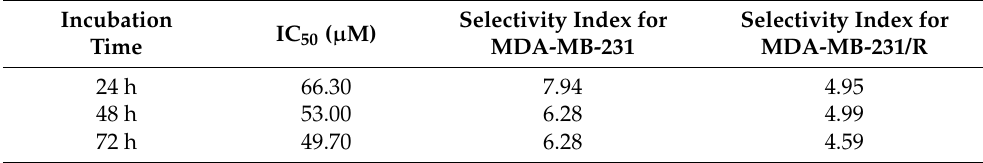
Table 3. Half-maximal inhibitory concentration (IC 50 ) of Pd 3 Spd 2 against MCF-12A cells at 24, 48 and 72 h of incubation regarding the suppression of cell